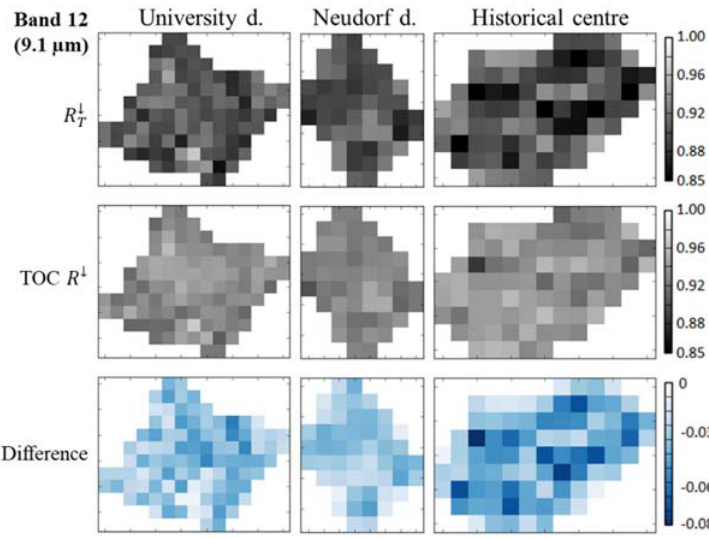
Figure 13. Emissivity maps derived from ASTER band 12 for each district using total downwelling TIR radiation ( R ↓ , 1st line), the top of canopy downwelling TIR radiation (TOC R ↓ , 2nd line) and the difference between both (3rd line). Table 5. Maximum, mean and standard deviation of the difference between emissivity estimated using total downwelling TIR radiation or top of canopy downwelling TIR radiation for each district (highest values in bold). Max ε Difference Mean ε Difference Std Dev. ε